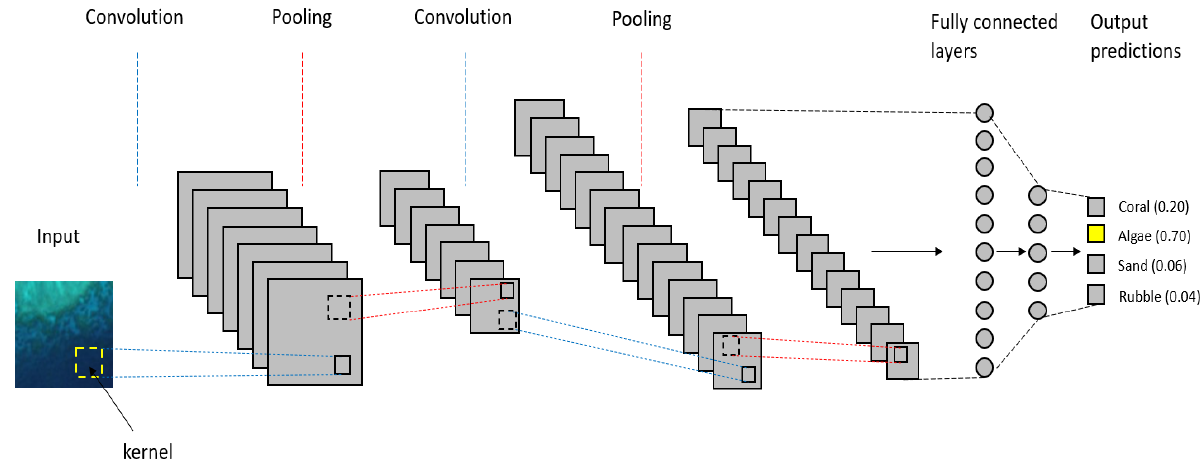
Figure 8. Illustration depicting a generic convolutional neural network consisting of convolutional, pooling, and fully connected layers.